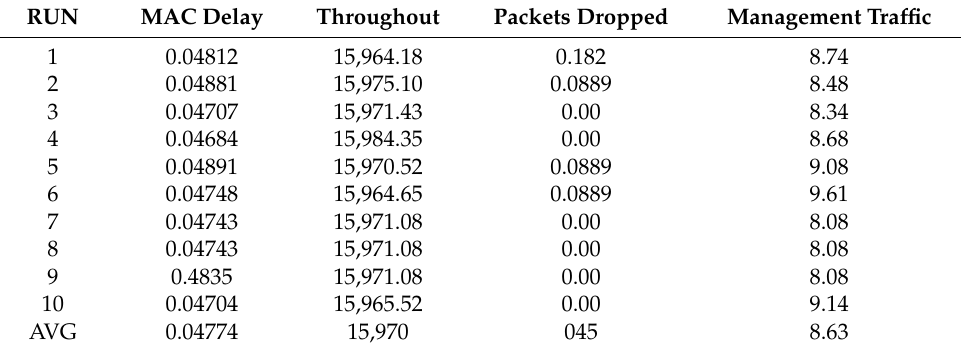
Table 3. Simple Scenario Counting Packets.